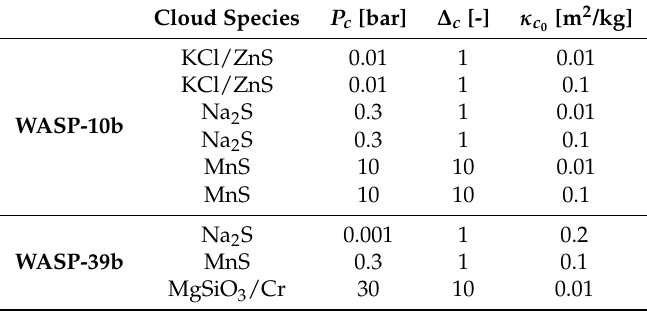
Table 2. Cloud deck parameters considered in this